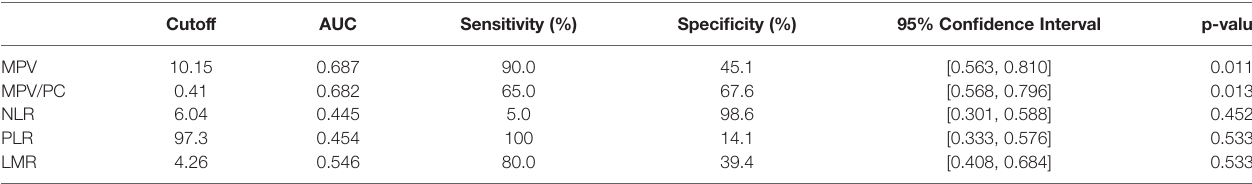
COS, Controlled ovarian stimulation; AUC, Area under the curve; CI, Con fi dence interval; MPV, Mean platelet volume; MPV/PC, Mean platelet volume-to-platelet count ratio; NLR, Neutrophil-to-lymphocyte ratio; PLR, Platelet-to-lymphocyte ratio; LMR, Lymphocyte-to-monocyte ratio.